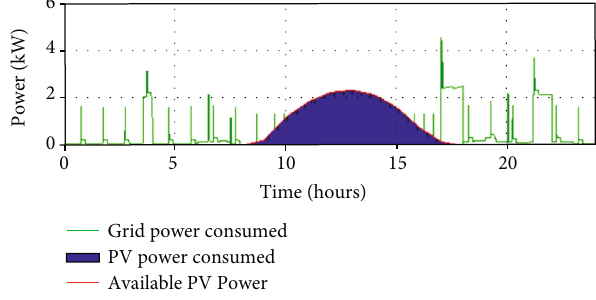
Figure 30: Nanogrid power consumption with EMS.